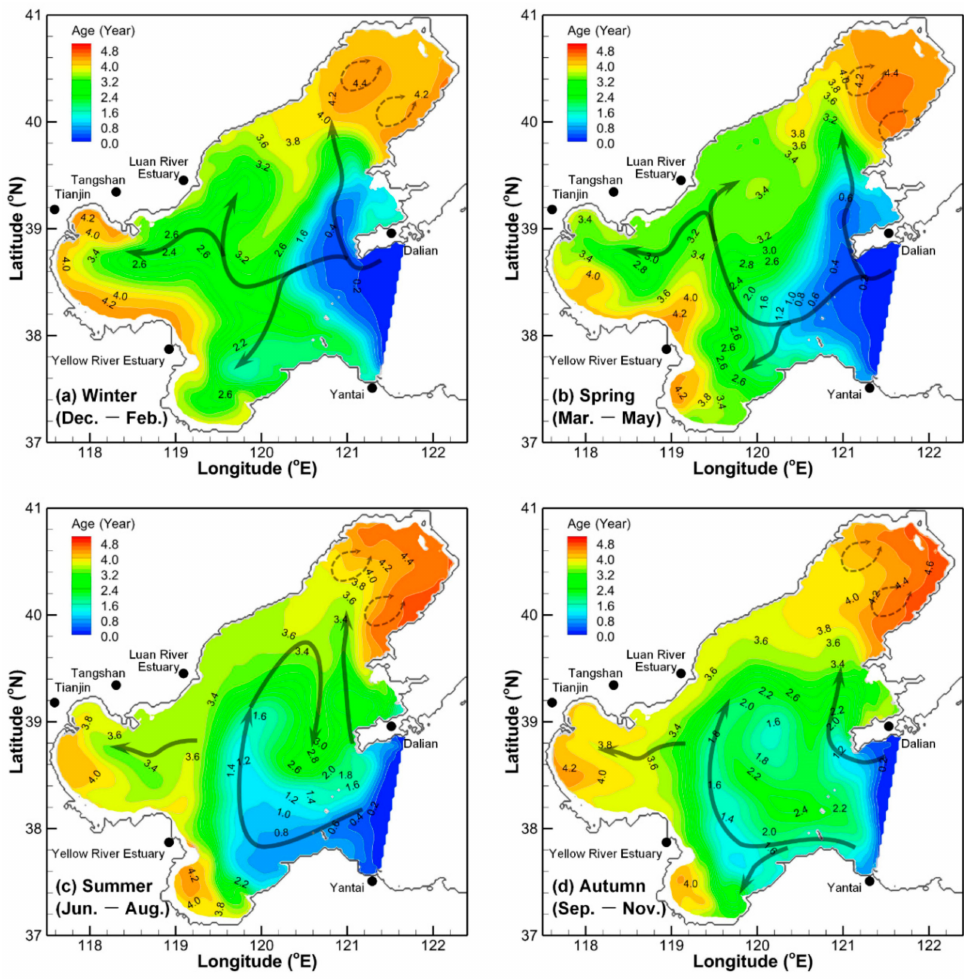
Figure 6. Seasonal-averaged age distributions in the Bohai Sea driven by the tides and wind. The solid arrows represent the long-term water transport deduced from the age distribution.